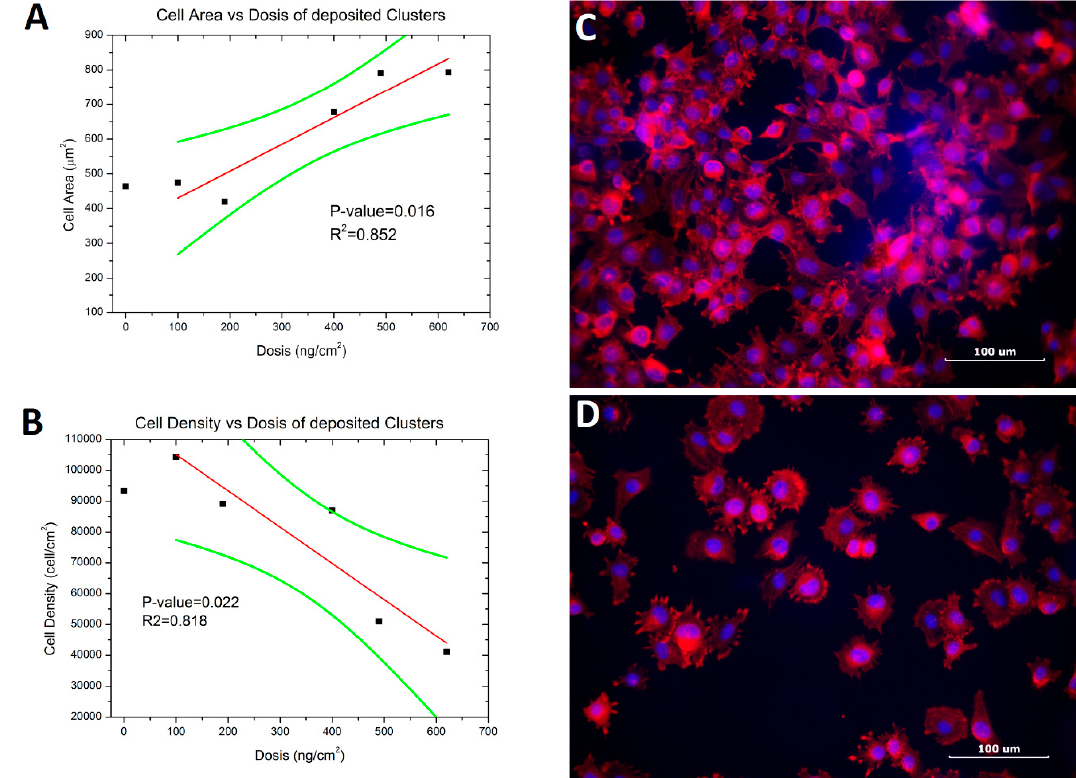
Figure 4. Cell spreading test on glass with nanoclusters of Ag. ( A ) Shows the cellular adhesion density on the different samples as a function of Ag concentration. The red line is the linear fitting and the green is the confidence band (95%). ( B ) Shows the adhered cell size as a function of Ag concentration. The red line is the linear fitting and the green is the confidence band (95%). ( C ) Fluorescence image of cells on the 100 ng/cm 2 sample 5. ( D ) Fluorescence image of cells on the 620 ng/cm 2 sample 1. In all images, the linear fit of the blank sample was not included.